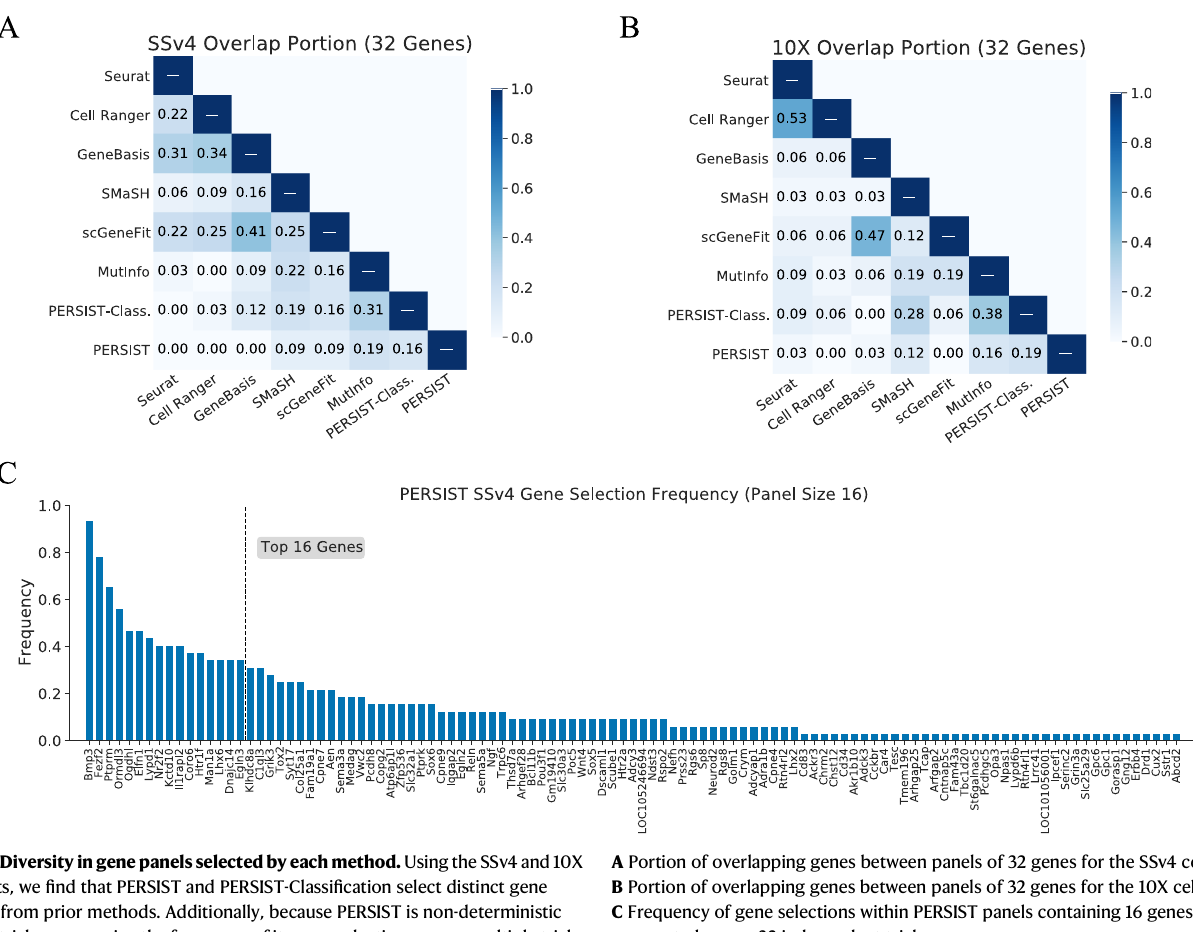
A Portion of overlapping genes between panels of 32 genes for the SSv4 cells. B Portion of overlapping genes between panels of 32 genes for the 10X cells. C Frequency of gene selections within PERSIST panels containing 16 genes, aggregated across 32 independent